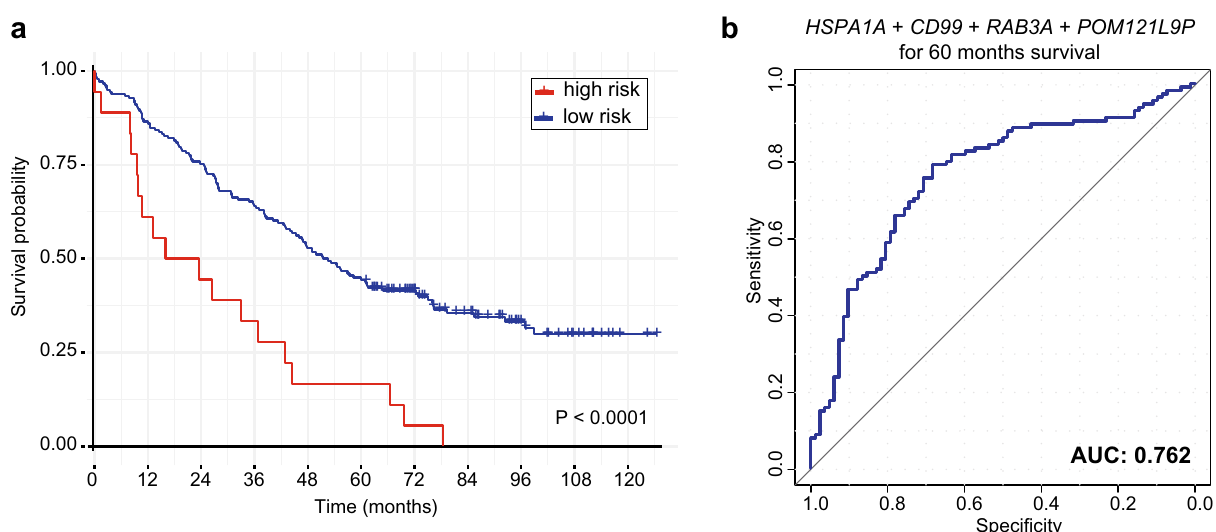
Figure 2. Overall survival and prediction performance of the 4 candidates. ( a ) Survival curve shows that “high risk” (all candidates overexpressed) group has a shorter survival compared to “low risk” (at least one candidate down regulated) OC patients. ( b ) AUC/ROC curve of combination of HSPA1A , CD99 , RAB3A and POM121L9P for 5-year OS. P value and AUC are presented